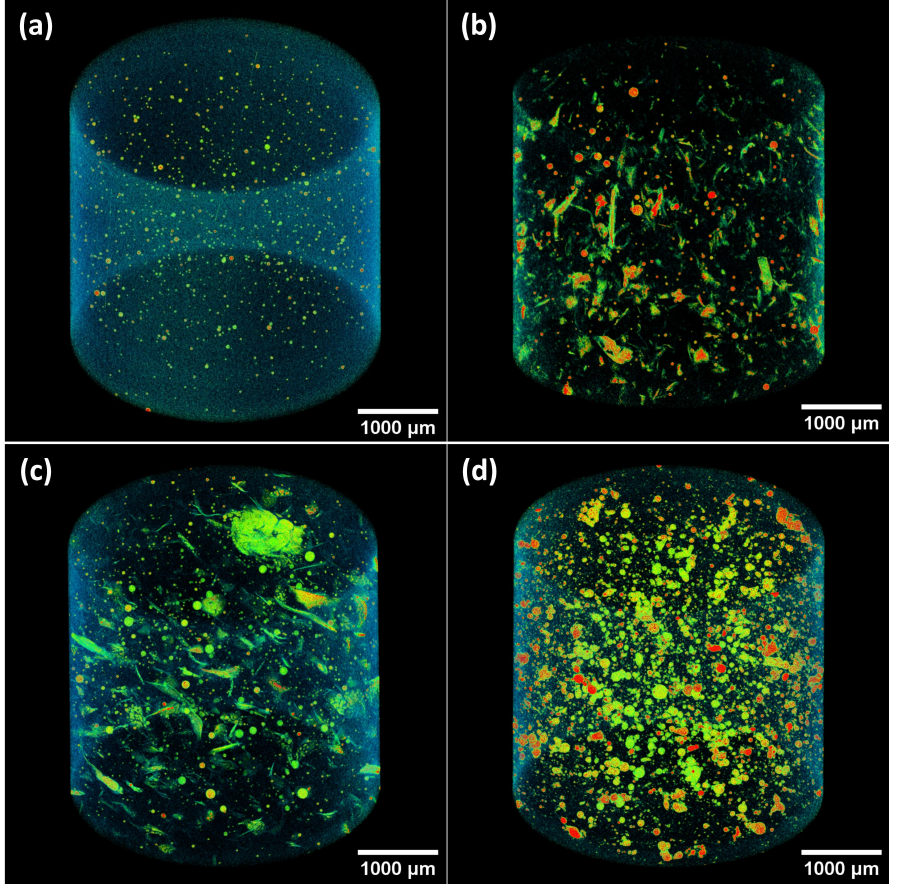
Figure 7. 3D Micro-CT reconstruction of electrospun-fiber-reinforced geopolymer composites: ( a ) Pure KGP. ( b ) KGP-0.5%PAN-W. ( c ) KGP-0.5%PAN-WG. ( d ) KGP-0.5%PEO-WG. Geopolymer matrix was filtered and the reddish color indicates existence of